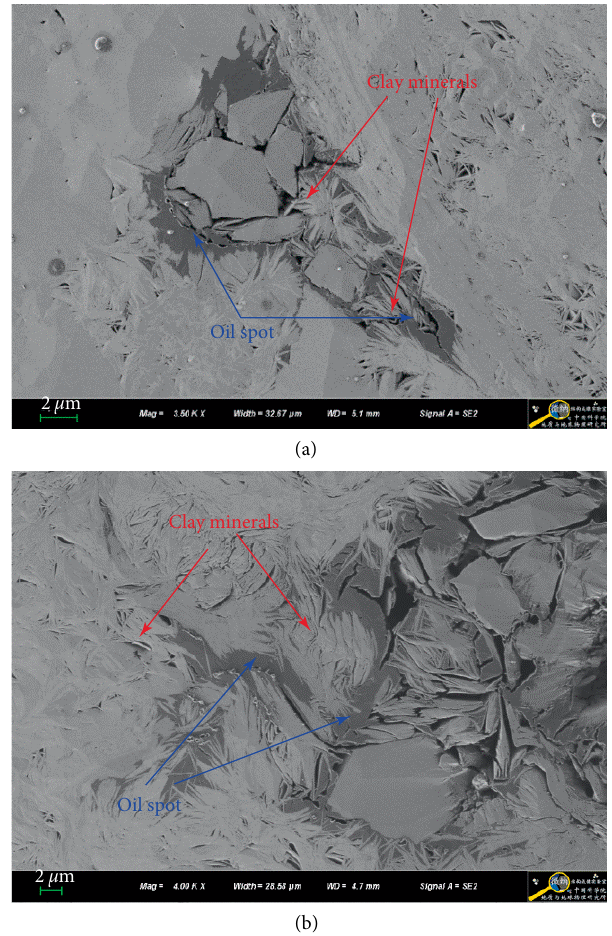
Figure 5: The oil distribution characteristics in matrix